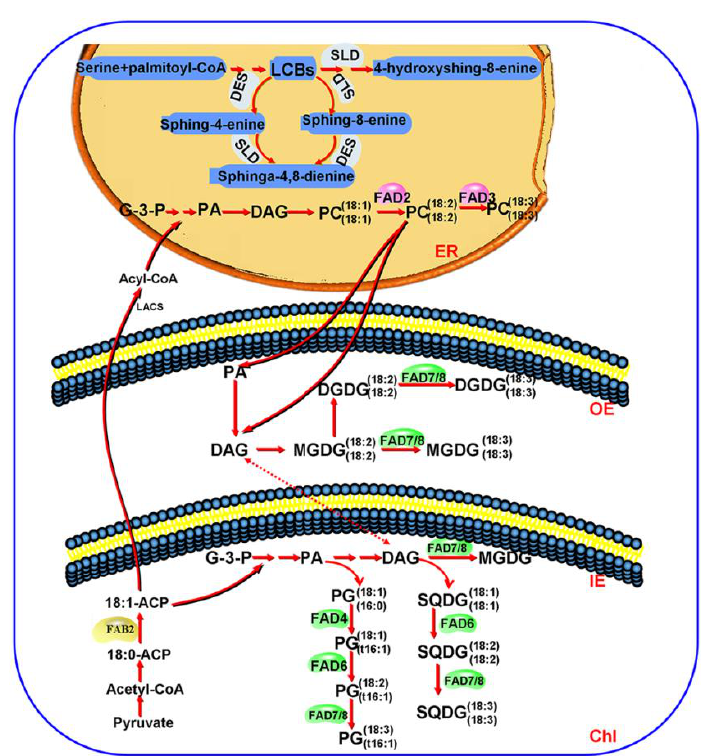
Figure 9. Diagram presenting the roles of fatty acid desaturases in the lipid metabolism of maize. ER: Figure